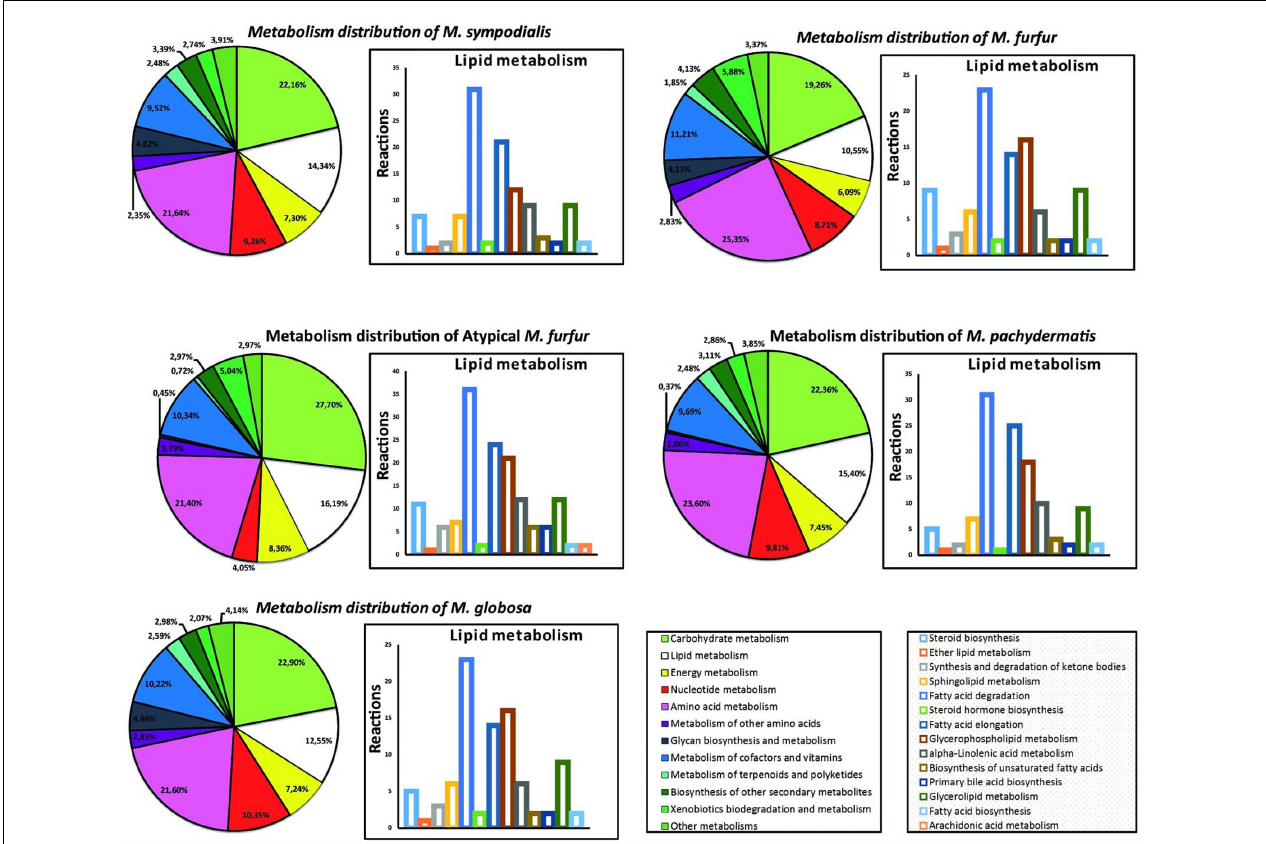
FIGURE 4 | Metabolism distribution predicted from each species and an expanded distribution for the lipid metabolism.